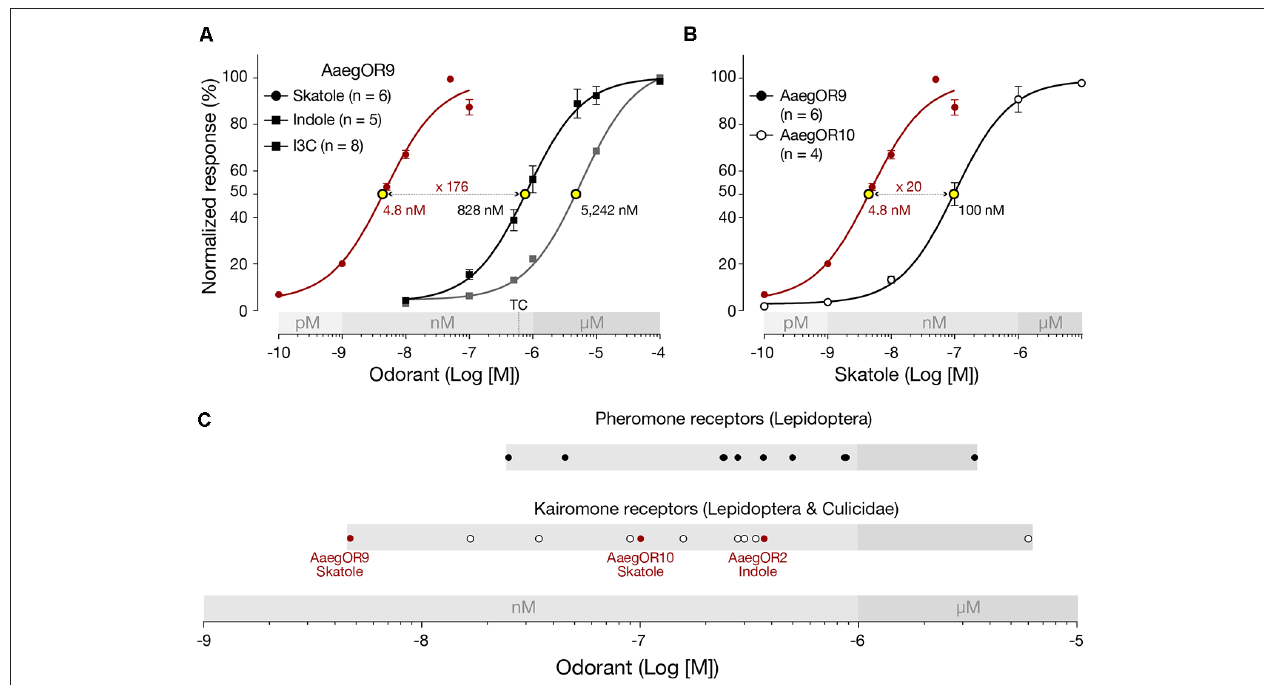
FIGURE 2 | Aedes aegypti OR9 (AaegOR9) is a supersensitive skatole receptor. (A) Based on their respective EC 50 values (yellow dots), AaegOR9 is significantly (one-way ANOVA followed by Tukey’s post test; p < 0.0001) more sensitive to skatole than to indole or to indole-3-carboxaldehyde (I3C). The concentration (500 nM) to which the tuning curve is based on is indicated by “TC.” (B) AaegOR9 is a more sensitive skatole receptor than AaegOR10 ( t -test; p < 0.01). (C) Sensitivity ranking (according to EC 50 values of cognate receptor-semiochemical interactions) of pheromone and kairomone receptors ( Supplementary Table 2